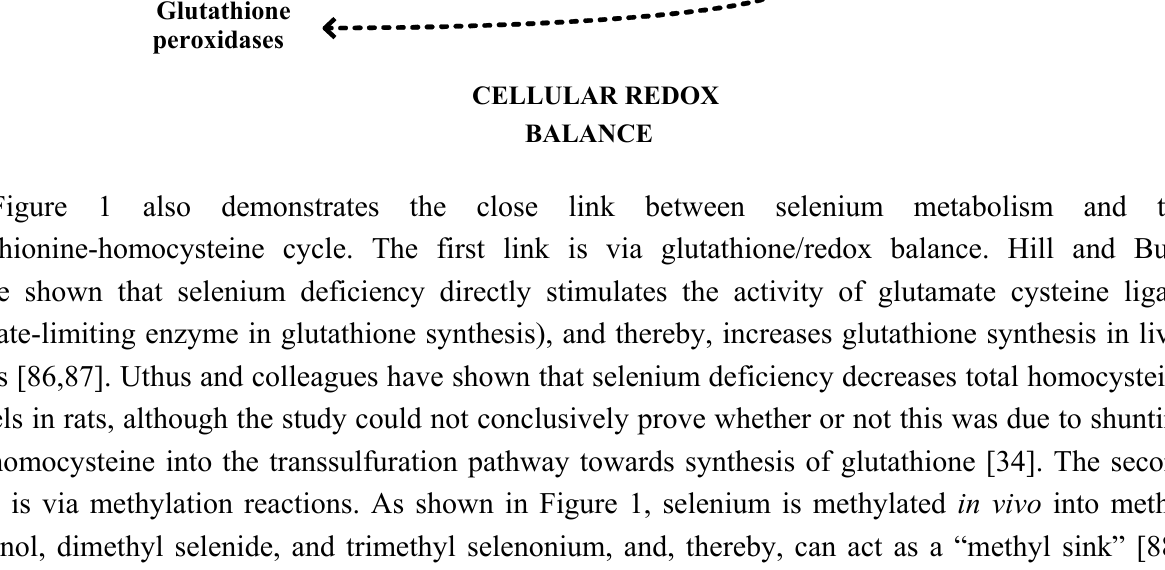
Figure 1 also demonstrates the close link between selenium metabolism and the methionine-homocysteine cycle. The first link is via glutathione/redox balance. Hill and